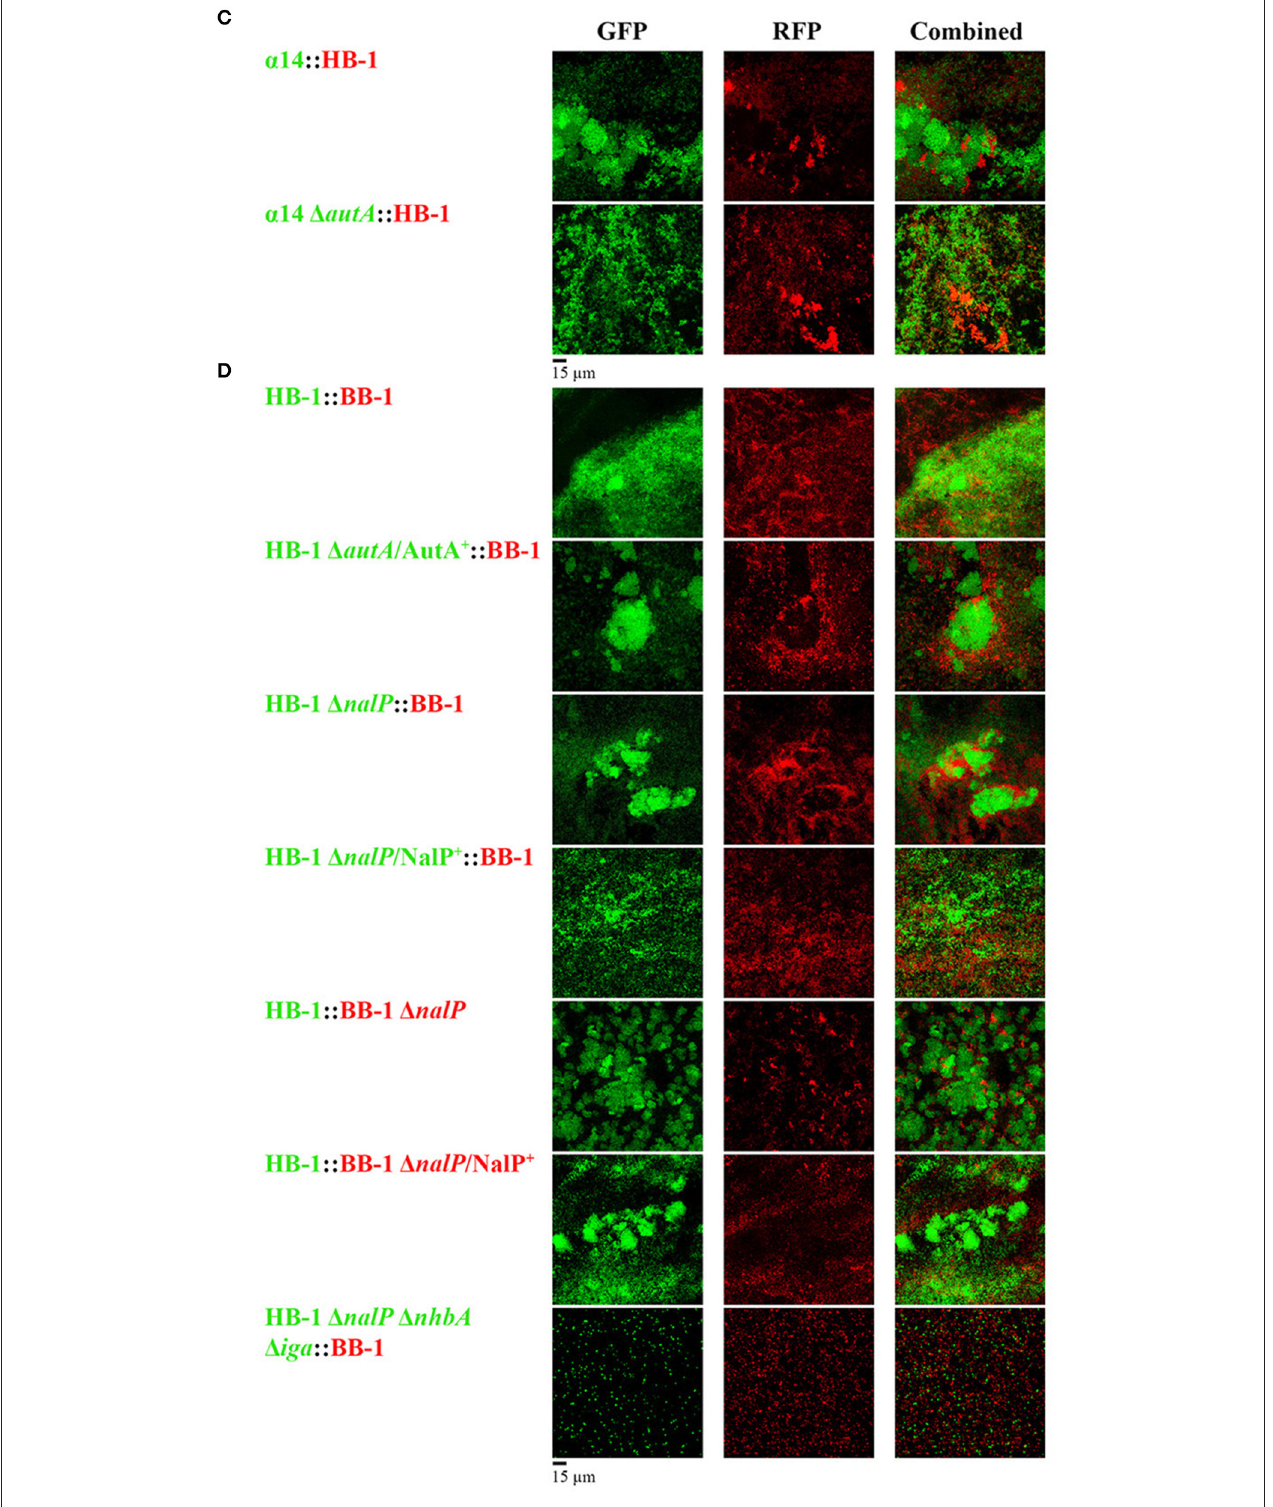
FIGURE 2 | Interbacterial interactions in dual-strain biofilms. (A) Biofilms constituted of two differently labeled derivatives of strain HB-1, α 14 or BB-1. In the enlargements of the BB-1 biofilms, the positions of three clusters are highlighted, one consisting exclusively of GFP-labeled cells, one consisting exclusively of RFP-labeled cells, and one intermixed cluster consisting of both GFP- and RFP-labeled cells. (B) Combinations of α 14 and BB-1 and several mutant derivatives.